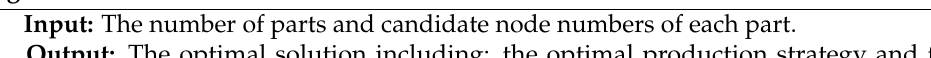
Algorithm 1 The utilized